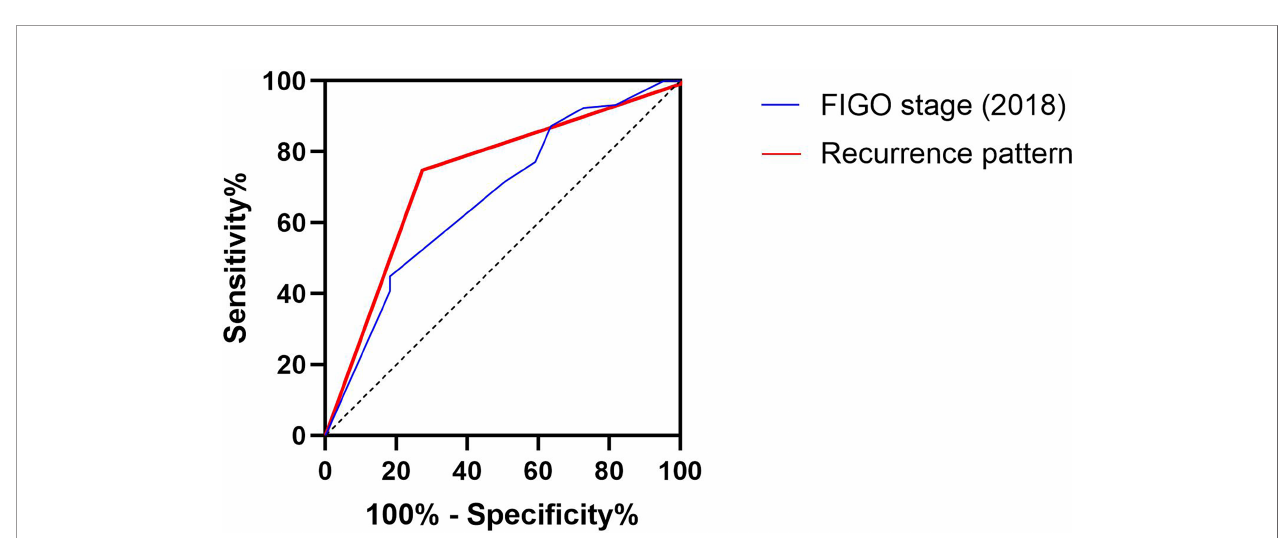
FIGURE 4 | Receiver operative characteristic (ROC) curve of the predictive accuracy for OS of patients by FIGO stage (2018) and recurrence